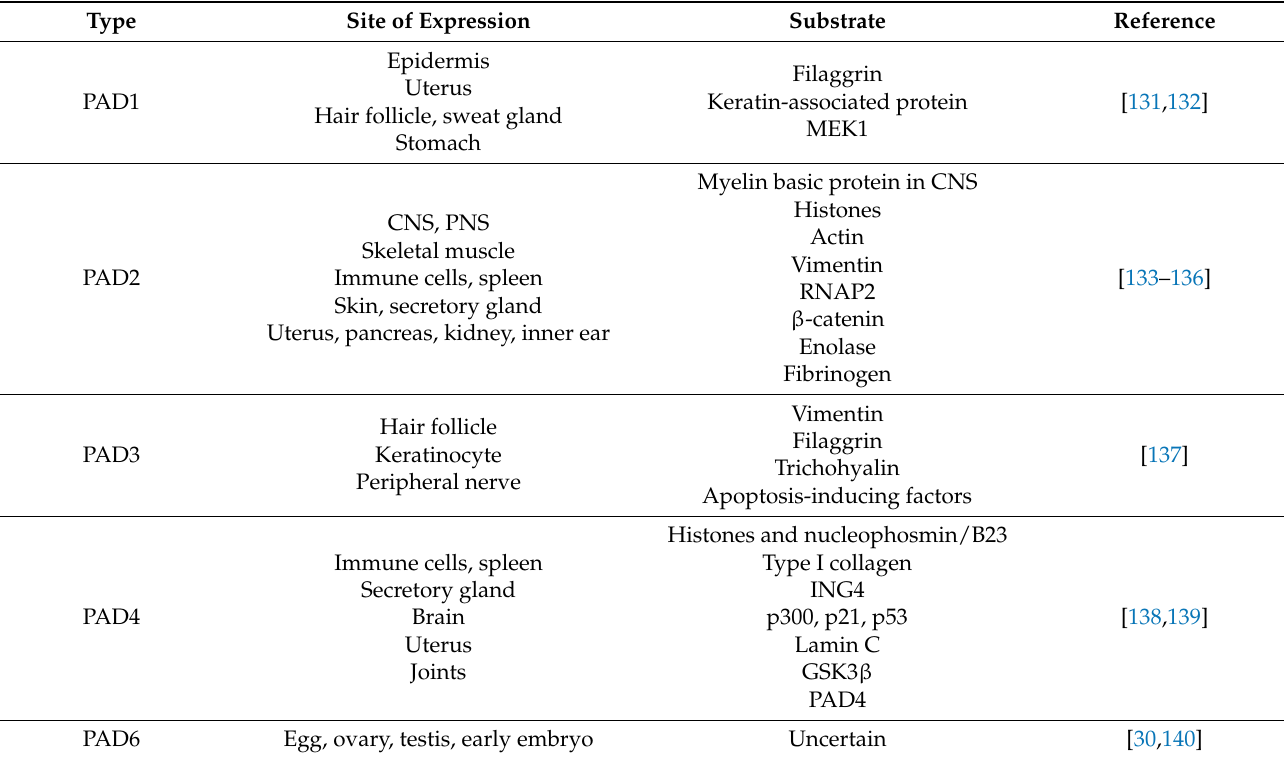
Table 3. Isoforms of peptidylarginine deiminase (PAD) compared with PAD of Porphyromonas gingivalis (PPAD).